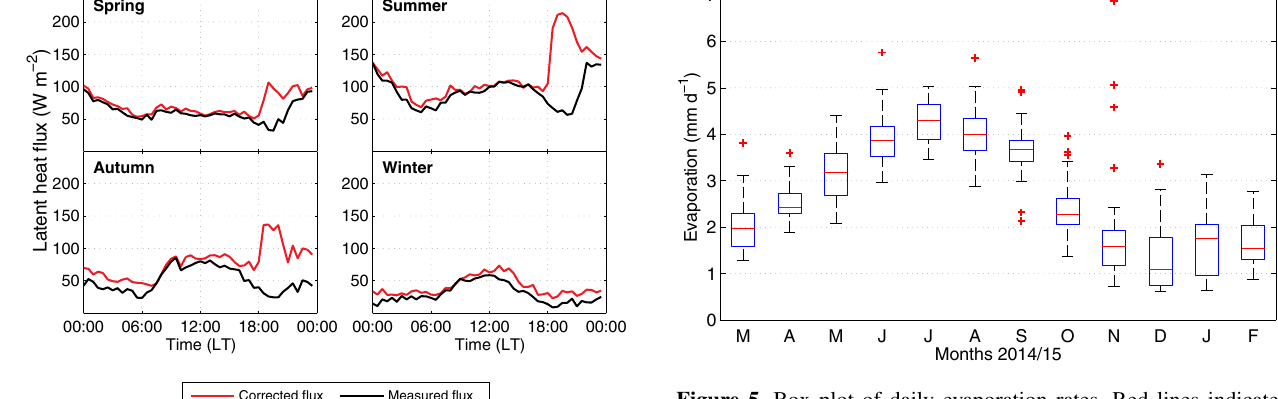
Figure 5. Box plot of daily evaporation rates. Red lines indicate medians, the edges of the boxes are the 25th and 75th percentiles, the whiskers extend to the most extreme data points not considered outliers, and outliers are plotted individually by red